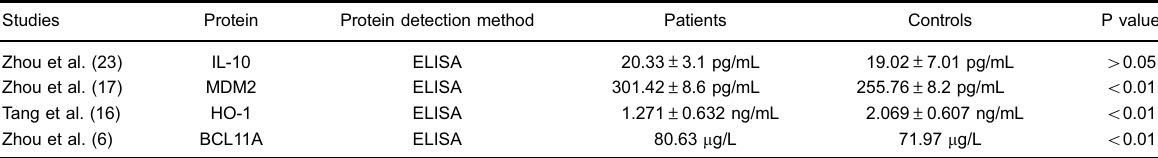
Table 5. Plasma levels of proteins in patients with vocal fold leukoplakia and control group.